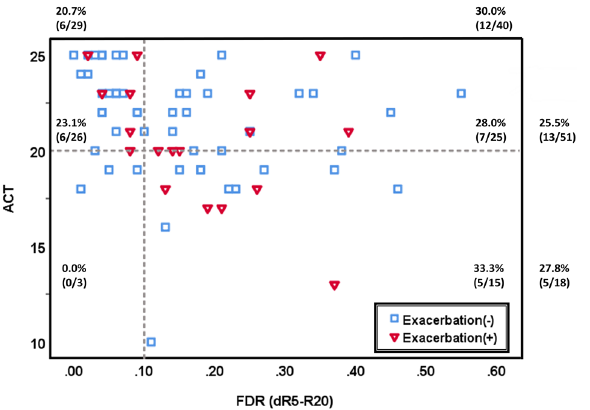
Figure 3. Distribution of ACT score, FDR, and frequent exacerbations in the study population. Based on the distribution of ACT and FDR, 30% of patients with FDR ≥ 0.10 (dashed line) experienced frequent exacerbations (once per year of severe acute exacerbation or twice per year of moderate acute exacerbation), and 27.8% of patients with ACT < 20 (dashed line) experienced frequent exacerbations. There were higher proportions of frequent exacerbations in patients with FDR ≥ 0.10 and ACT < 20, but the statistical difference in group comparisons was not met. Abbreviation ACT, asthma control test; FDR, frequency-dependent resistance; difference in resistance at 5 Hz and 20